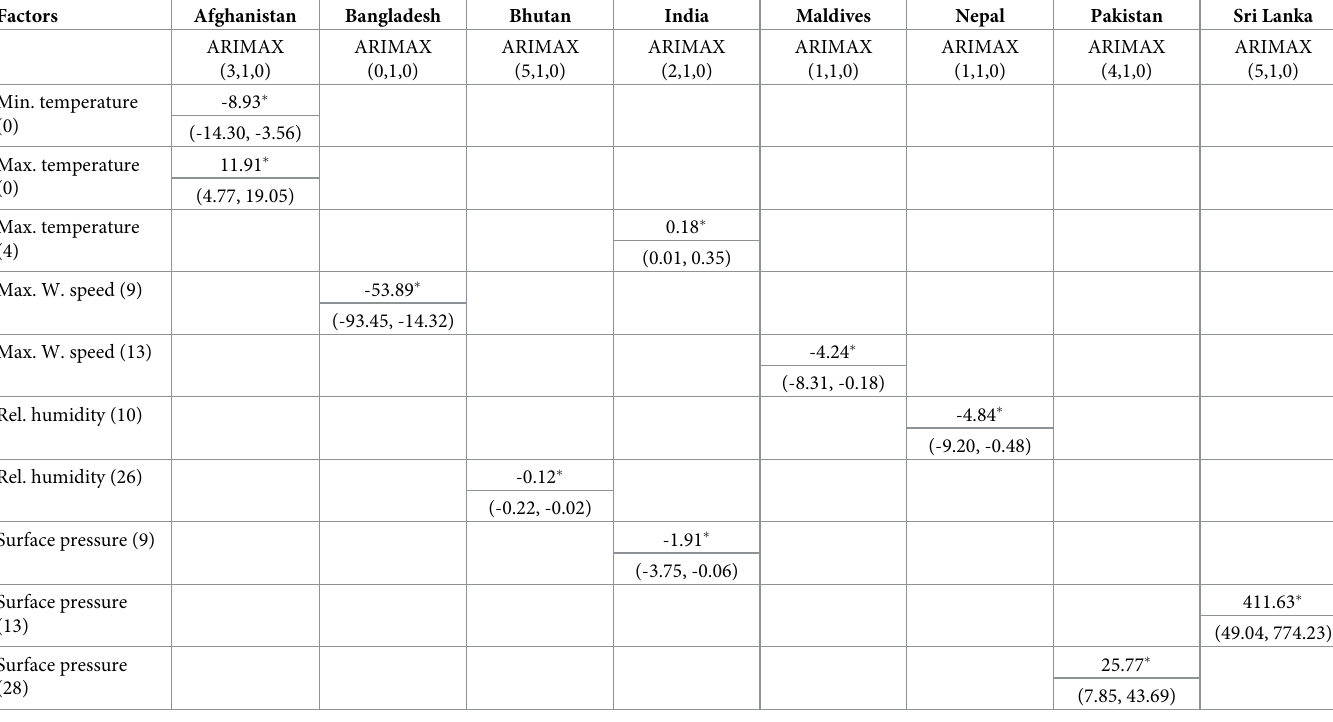
Table 2. Estimated parameters with 95% confidence intervals of significant meteorological factors of ARIMAX